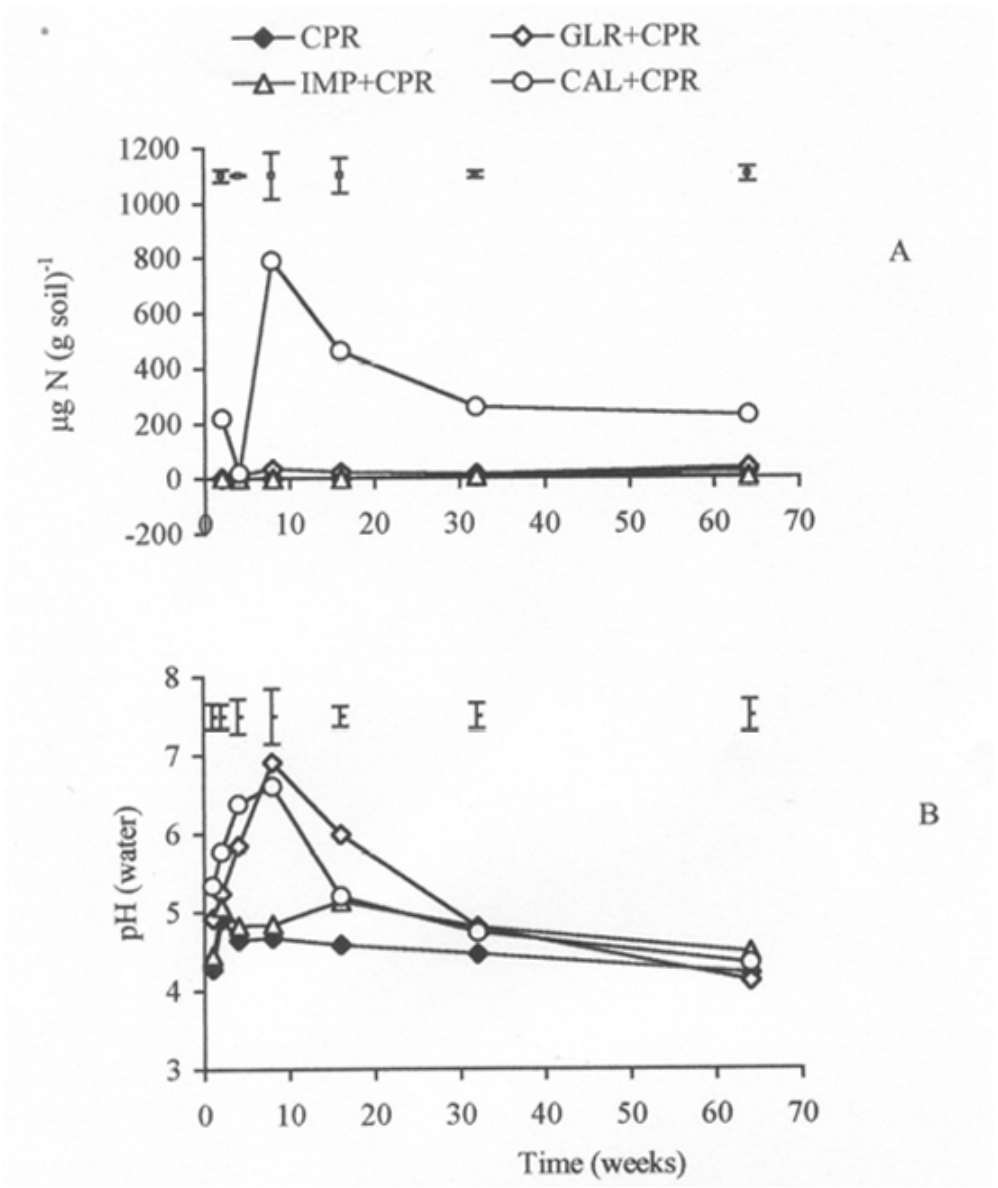
FIGURE 3. NH 4 -N accumulation (A) and pH changes (B) in a tropical soil treated with GMs and PRs. CPR = China PR; bars = LSD 0.05